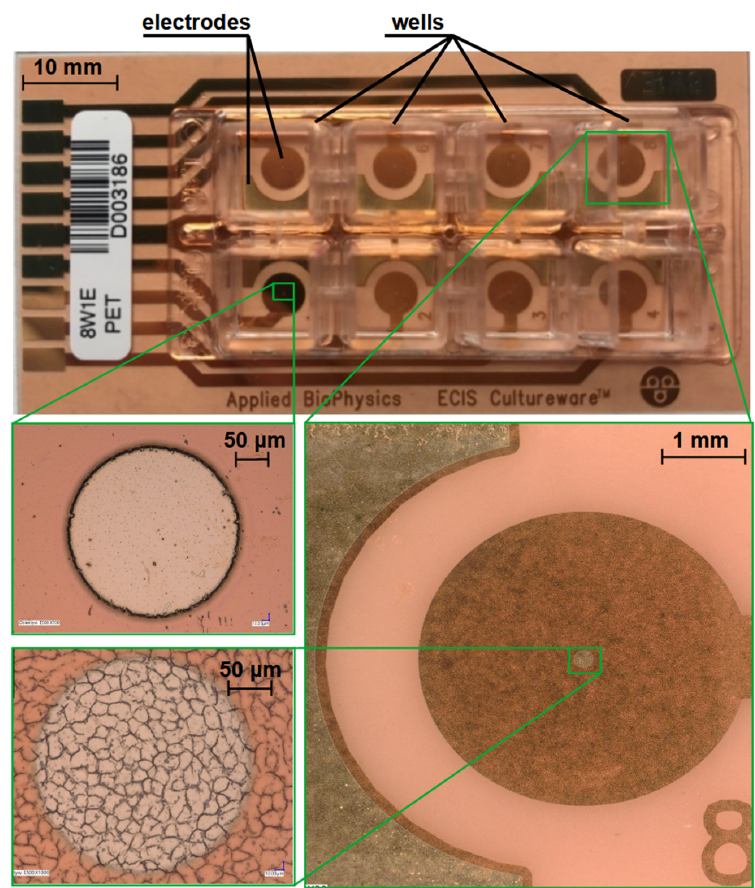
Figure 8. The microscopic images of the array of eight ECIS sensors with the cells after 93 h. In the picture with the highest magnification, the monolayer of cells is visible. On the left is a zoom of the electrode in well #1 without cells ( top ) and the electrode in well #8 ( bottom ) containing a monolayer of cells.